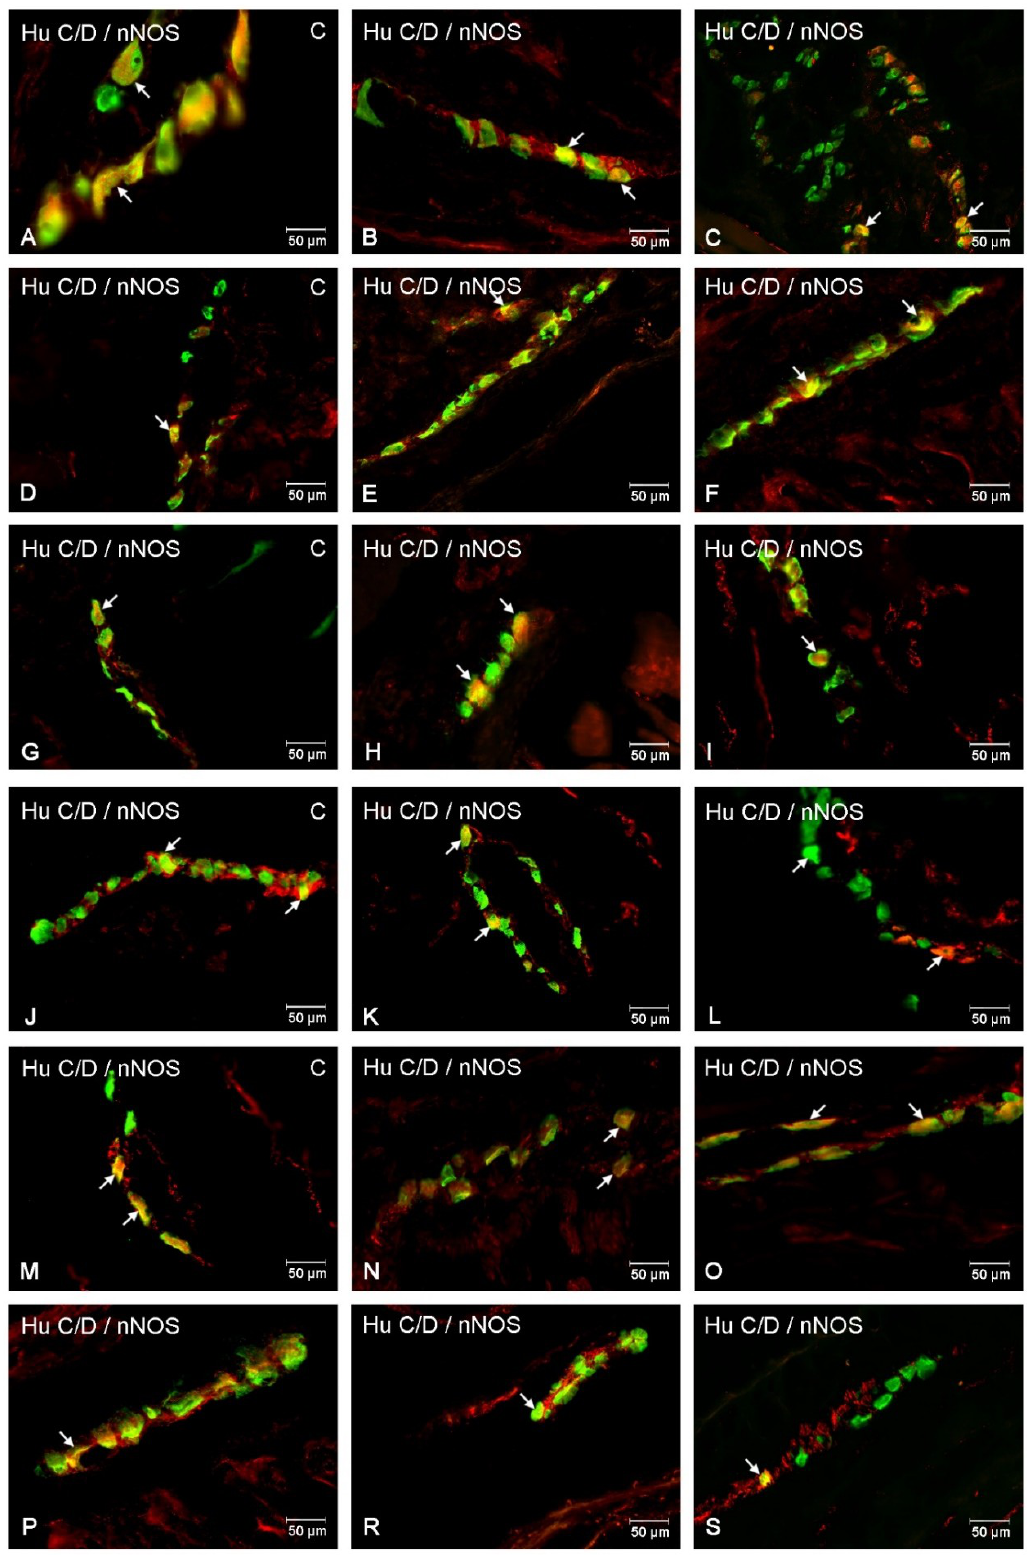
Figure 2. Intramural plexuses in the porcine duodenum, jejunum and ileum immunoreactive to nNOS. Myenteric plexus in the duodenum ( A , D ), jejunum ( B , E ) and ileum ( C , F ) under physiological conditions (A–C) and after streptozotocin administration (D–F). All photographs have been created by digital superimposition of two-colour channels (green for Hu C/D- used here as a pan-neuronal marker and red for nNOS). Neurons showing co-localization of Hu C/D and nNOS are indicated